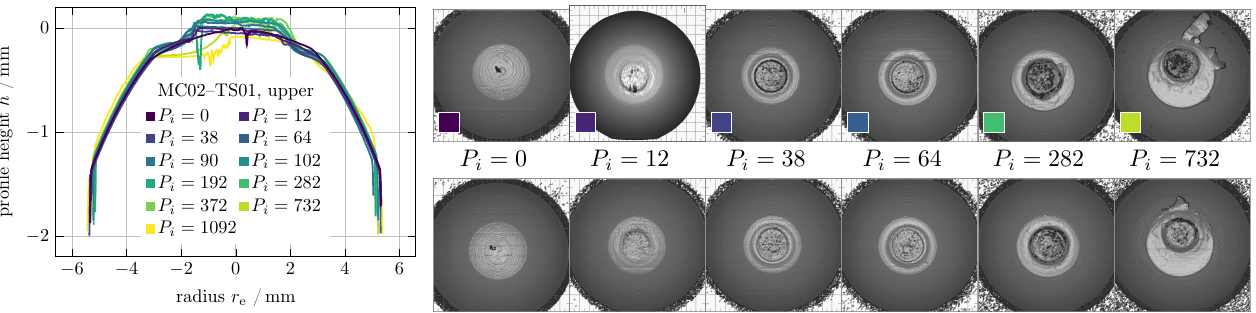
Figure 13. Wear mode of plateau forming visualized by topographical measurements of the upper (anode) and lower (cathode) electrodes of MC02–TS01 by profile sections and top view on 3D topographical measurements.